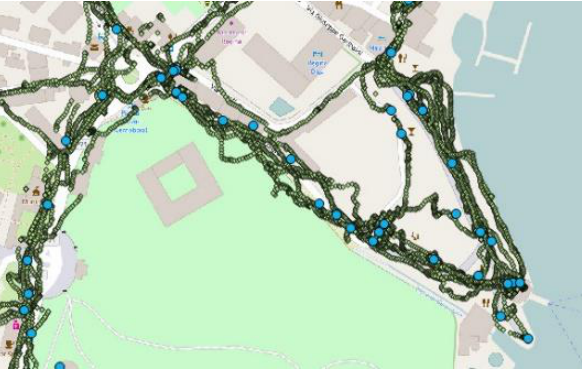
Figure 9 . Neurons computation from trajectories.